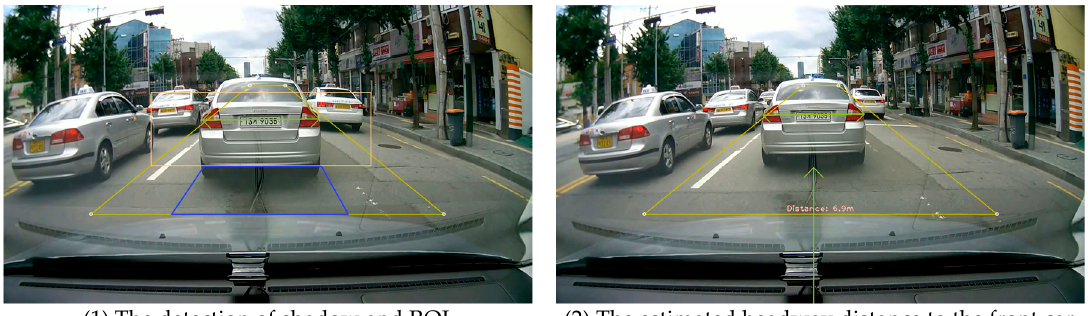
Figure 11. The implemented results of the proposed model.